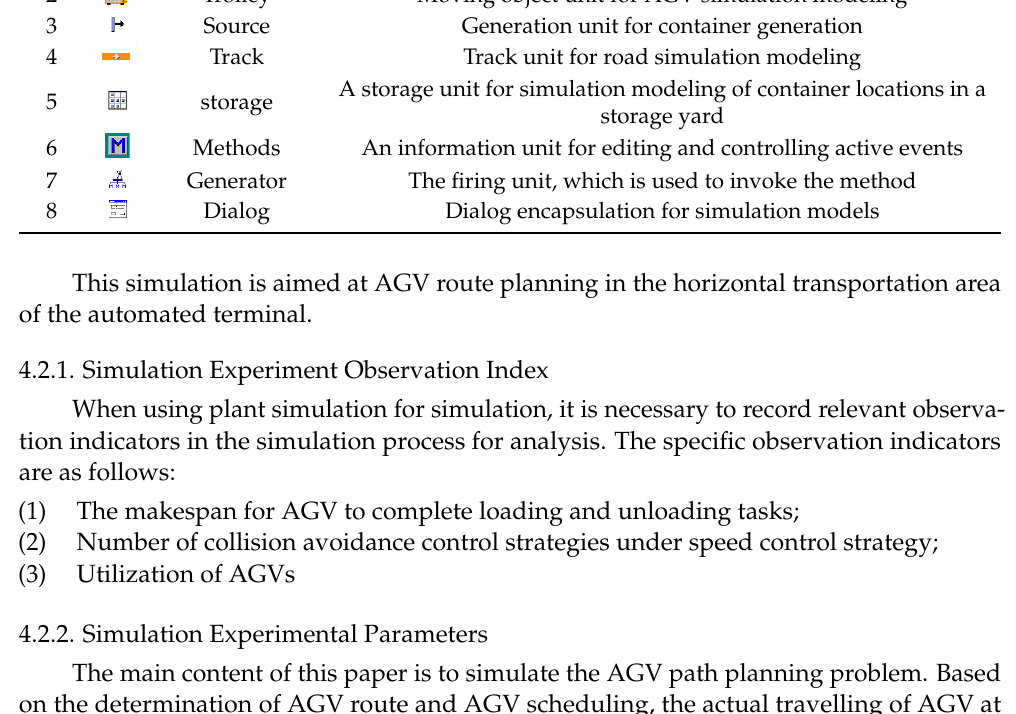
Figure 7. Simulation model layout diagram.